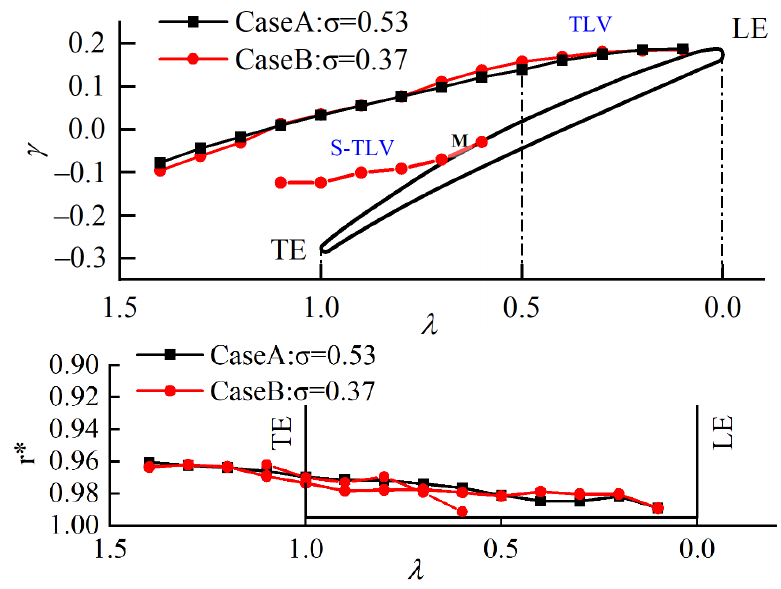
Figure 21. Distribution of vortex core trajectory.